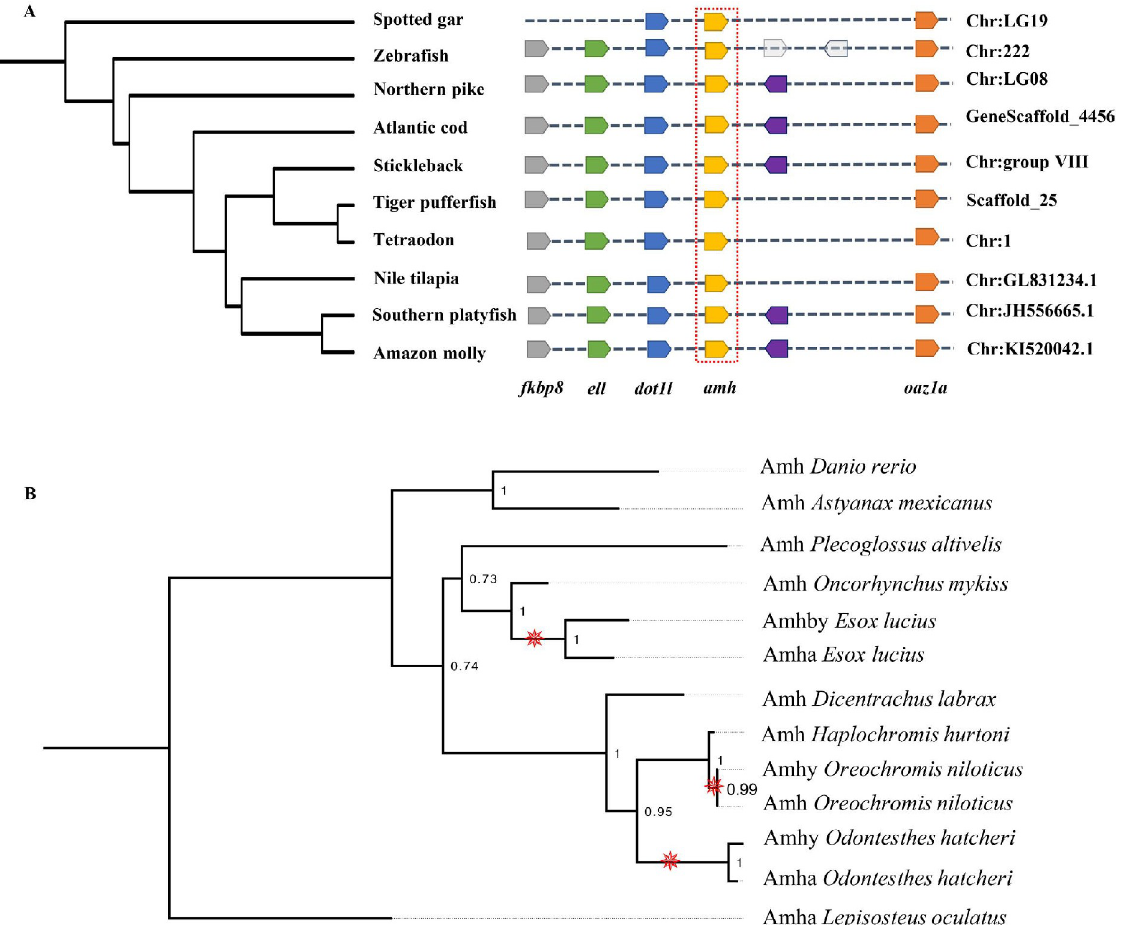
Fig 5. Evolution of Amh in teleosts. A : Synteny map of genomic regions around amh genes (highlighted by the red box) in teleosts. Orthologs of each gene are shown in the same color and the direction of the arrow indicates the gene orientation. Ortholog names are listed below and the genomic location of the orthologs are listed on the right side. For Northern pike ( Esox lucius ), amha , which is located on LG08, is used in this analysis. B : Phylogenetic reconstruction of teleost Amh protein orthologs. The phylogenetic tree was constructed with the maximum likelihood method (bootstrap = 1000). Numbers at tree nodes are bootstrap values. Spotted gar ( Lepisosteus oculatus ) Amh was used as an outgroup. Branches with Amh duplication are indicated by the red pinwheels.